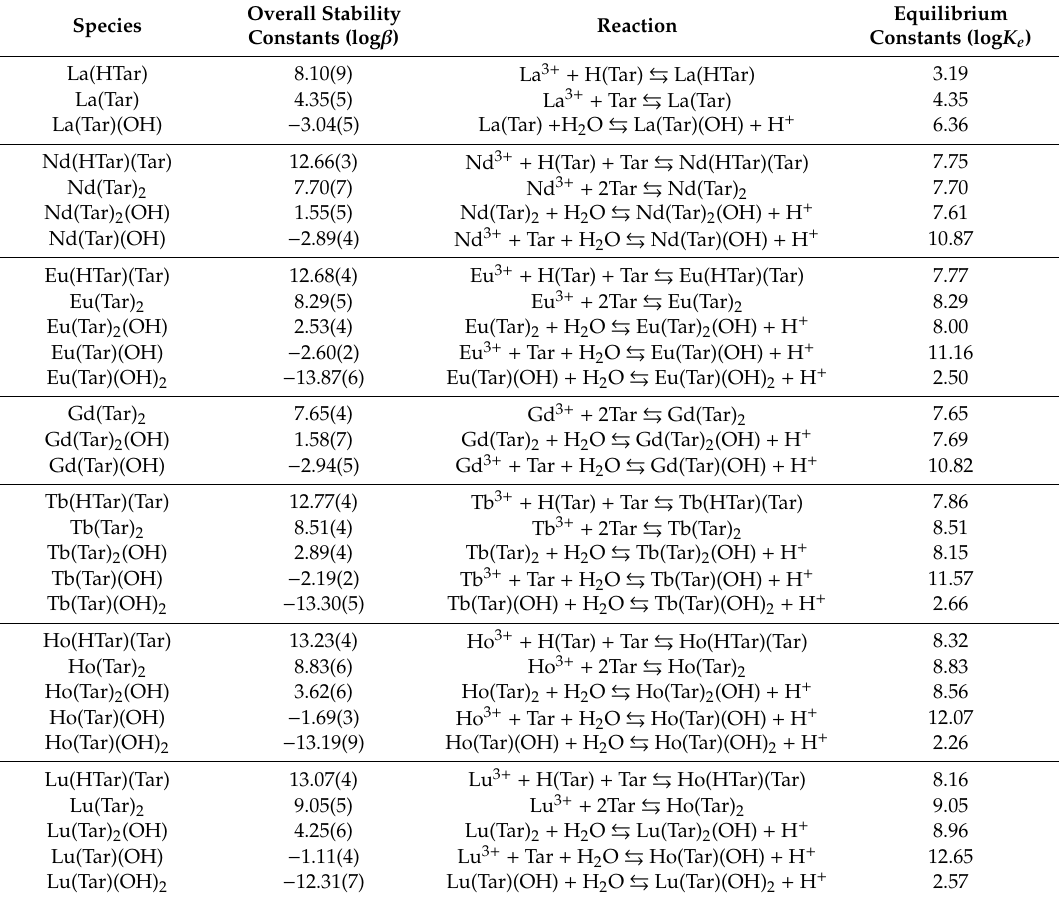
Table 2. Overall stability constants (log β ) and equilibrium constants of formation (logK e ) of binary complexes in the system of Ln(III) / tartaric acid (standard deviation are given in parenthesis).